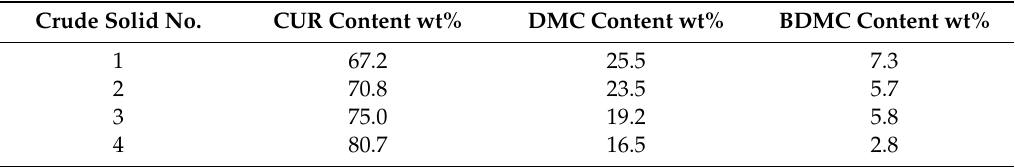
Table 2. Comparison of the crude solids purchased from Sigma Aldrich (crude solids No. 1–3) and Acros (crude solid no. 4), each representing a ternary mixture of the three CURDs. Crude Solid